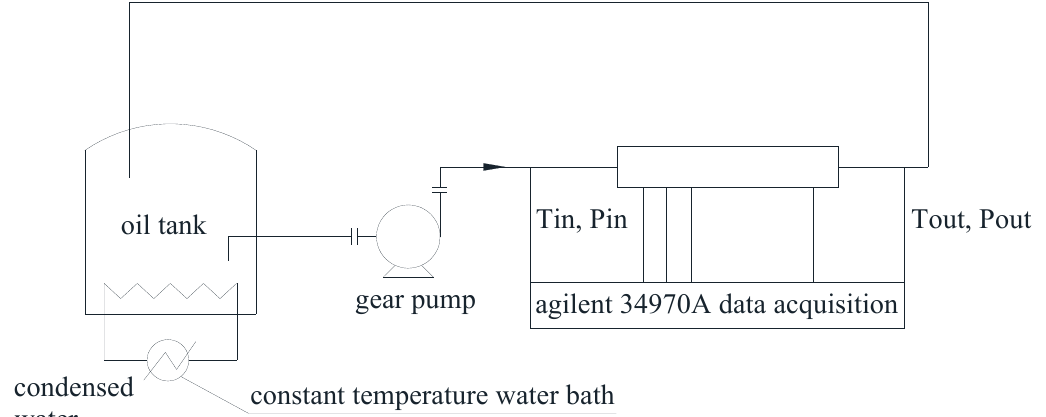
Figure 8. Schematic diagram of the experimental setup.